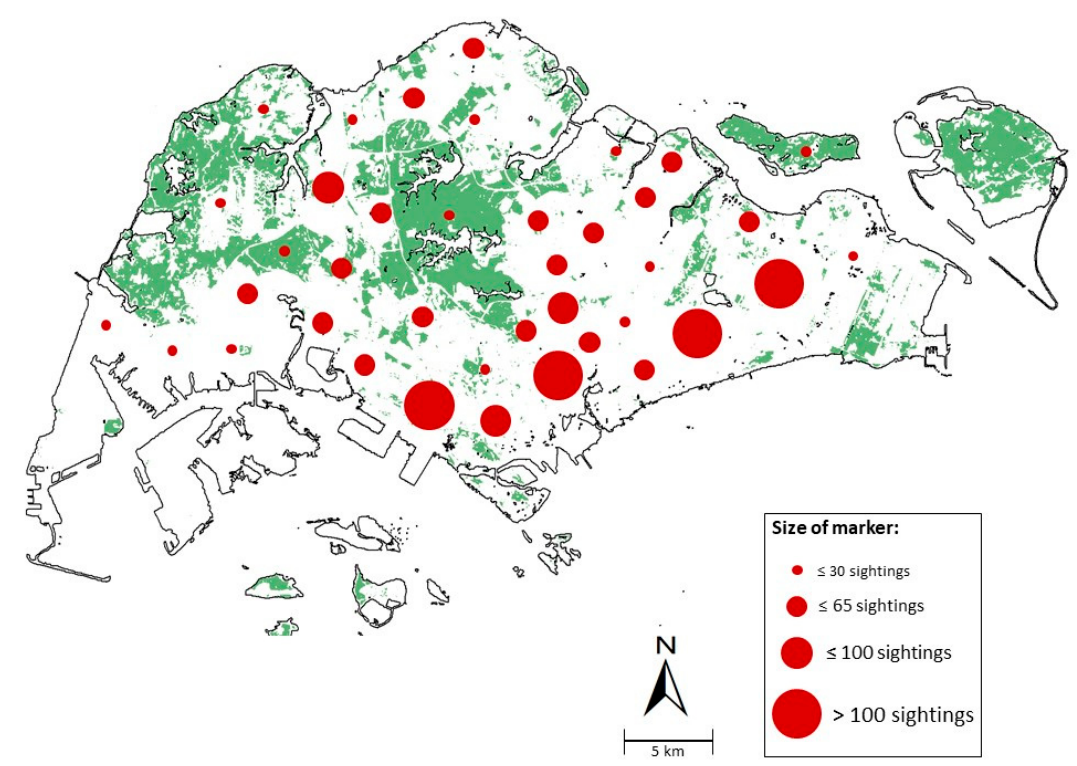
Figure 3. Number of sightings of L. zampa recorded in Habitatnews, iNaturalist and NSS across Singapore from 2011 to 2020 with a map scale of 1:50,000. Sightings within the Urban Redevelopment Authority Planning Zones were clustered and represented as a circle. Zones of relatively high sightings include Tampines (105 sightings) and Bedok (107 sightings) in the east, Queenstown (165 sightings) in the central west and the central business district in southern Singapore (>300 sightings). The base vegetation map was obtained from David Tan and used with permission.